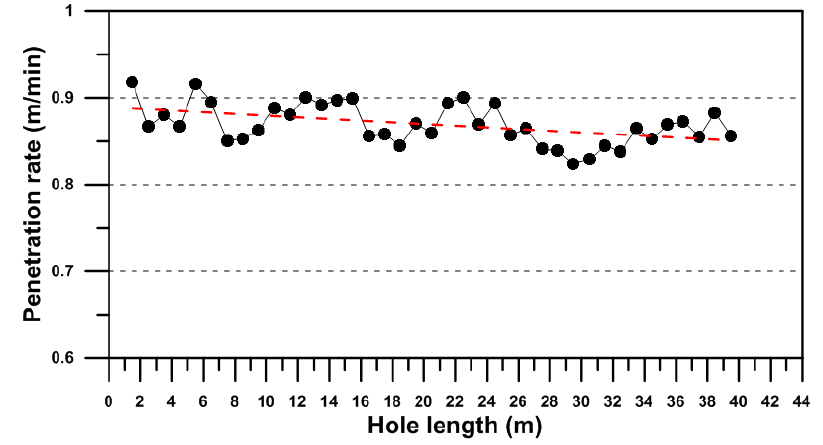
Figure 4. Penetration rate versus hole length.